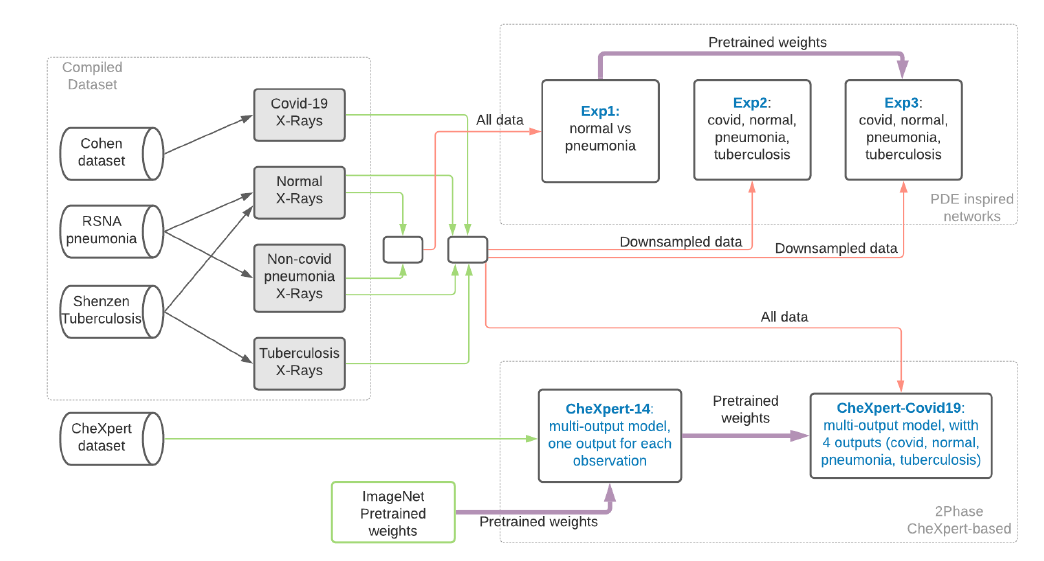
Figure 2. The proposed method for learning: compiling the dataset ( left ), employing partial differential equation (PDE)- inspired networks ( top-right ), and using CheXpert dataset in 2-phase transfer learning ( bottom-right